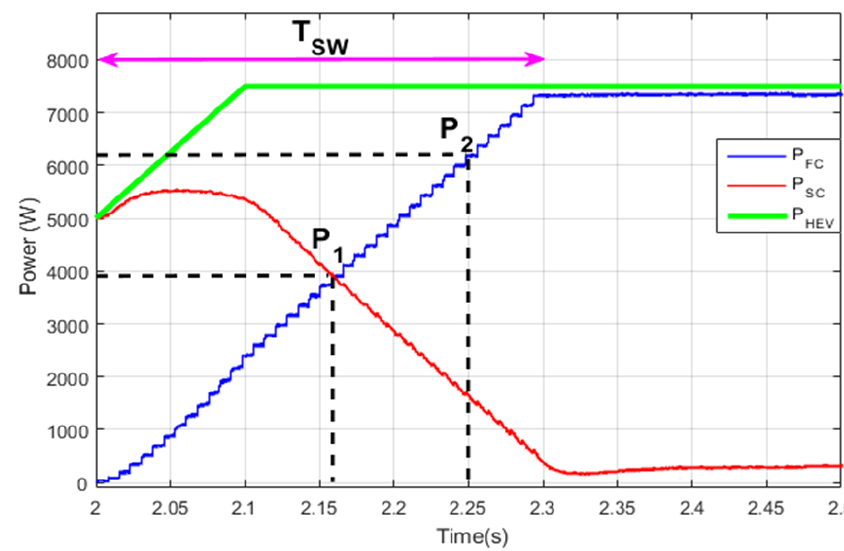
Figure 18. Stair-based power source switching.